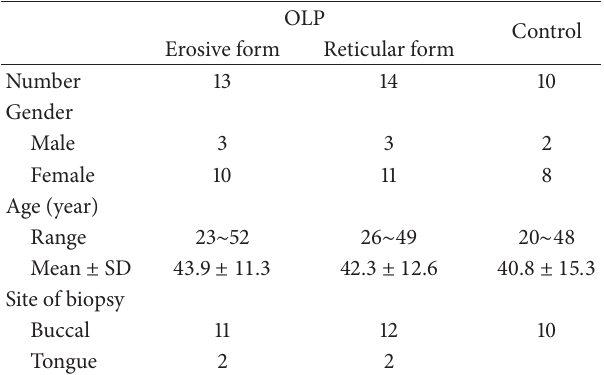
Table 1: Clinical features of the